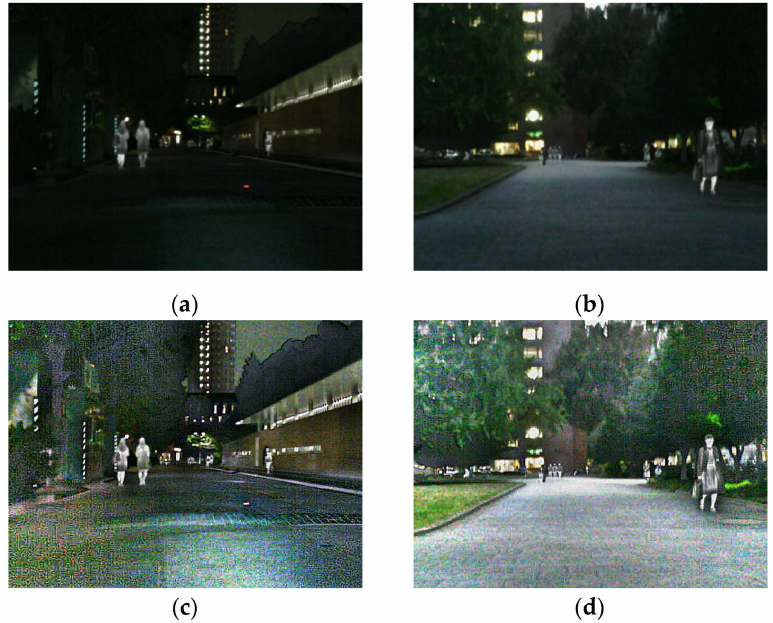
Figure 11. ( a , b ): random images from first two steps; ( c ): ( a ) after Retinex deillumination augmenta- tion; ( d ): ( b ) after Retinex deillumination